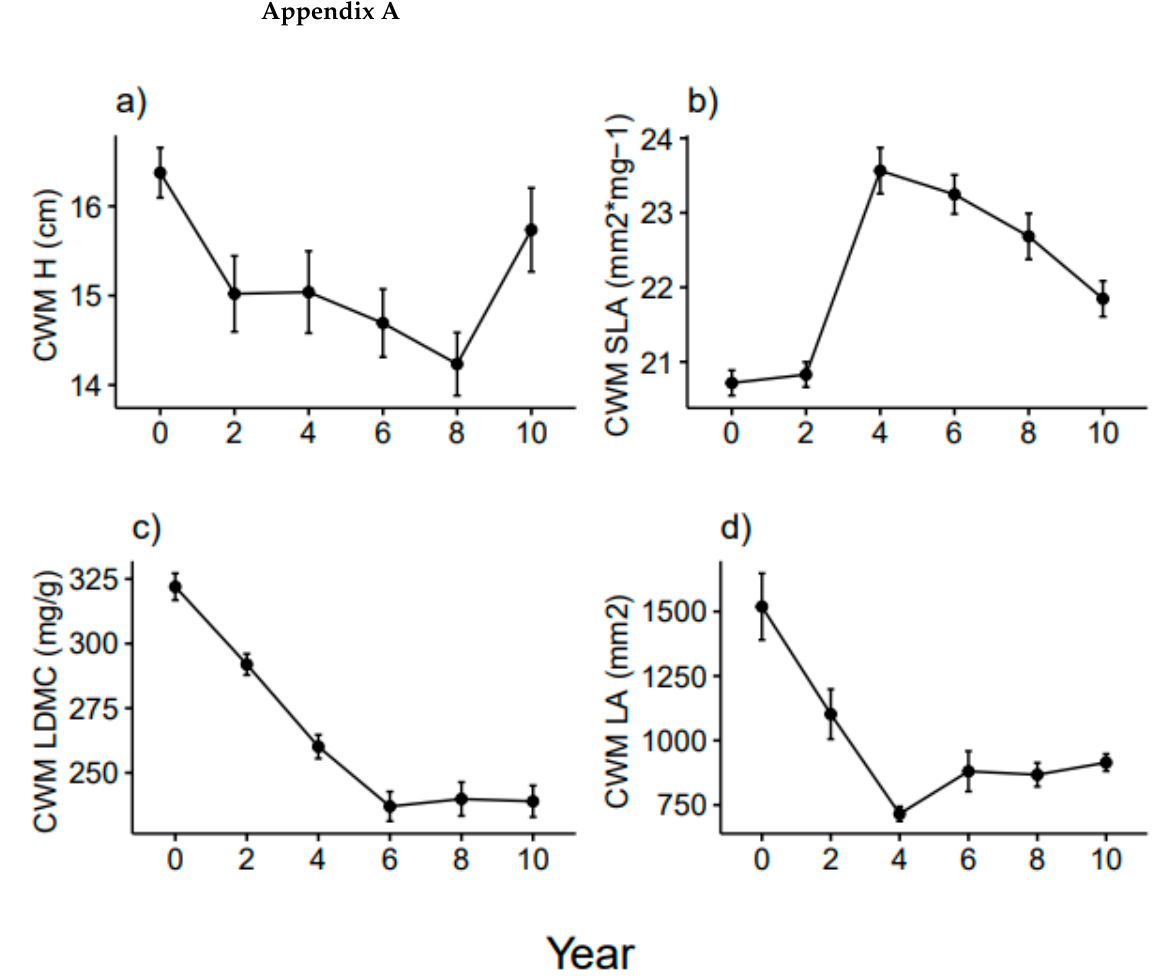
Figure A1. Mean ( ± s.e.) of raw community weighted means (CWMs), i.e., non-log 10 -transformed, for ( a ) plant height (H), ( b ) specific leaf area (SLA), ( c ) leaf dry matter content (LDMC), and ( d ) leaf area (LA) under twice-a-year mowing. Year 0 (before treatment) refers to 2010; years 2, 4, 6, 8, and 10 correspond to 2012, 2014, 2016, 2018, and 2020.